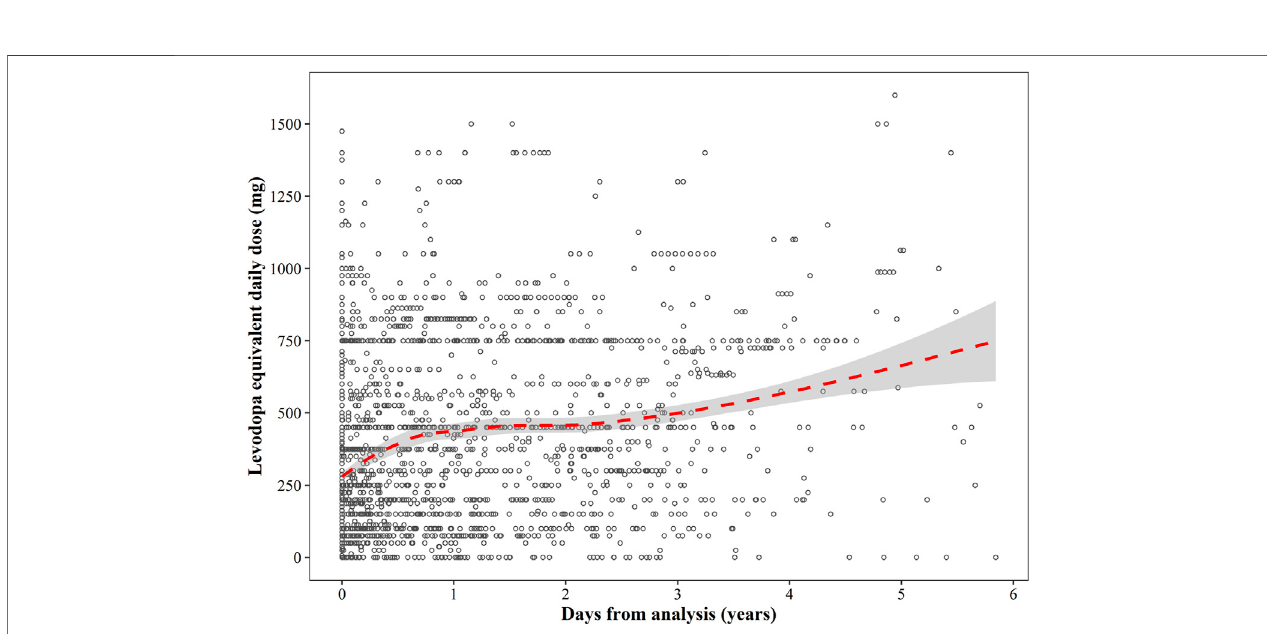
FIGURE5| Ascatterplotoftherelationshipbetweenlevodopaequivalentdailydoseanddiseaseduration.Thereddottedlinerepresentstheregressioncurve,and the grey shaded area represents 95% con fi dence interval of the regression line.